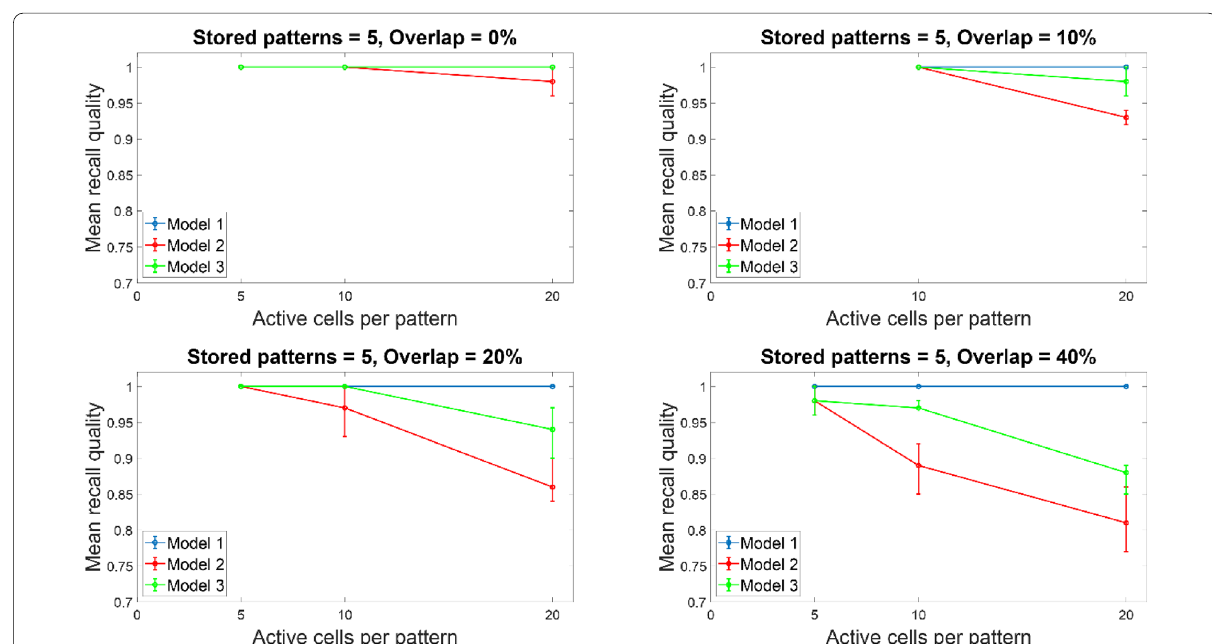
Fig. 10 Mean recall quality of ‘model 1’, ‘model 2’, and ‘model 3’ as a function of active cells per pattern (5, 10, 20) when five patterns were stored with various percentages of pattern overlap. Each model was a network of 100PCs, 1 BSC, and 1 OLM cell